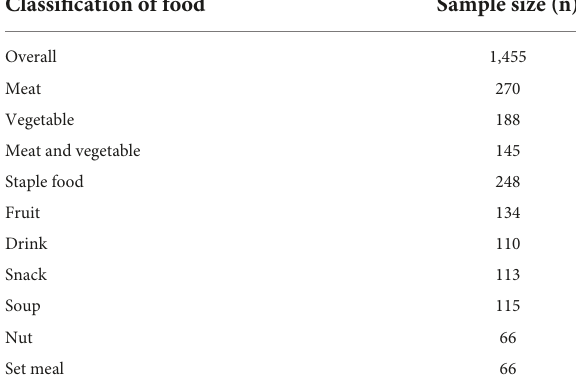
TABLE 1 Food recognition image sample